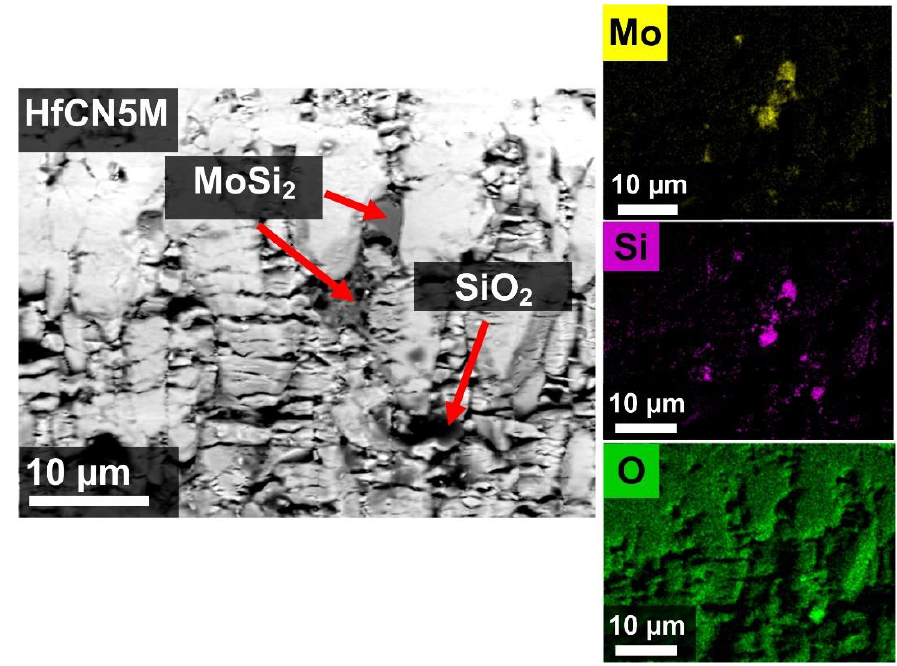
Figure 9. Local inclusions of MoSi 2 and SiO 2 in the HfCN5M oxide layer after isothermal oxidation in a furnace at 1000 °C.